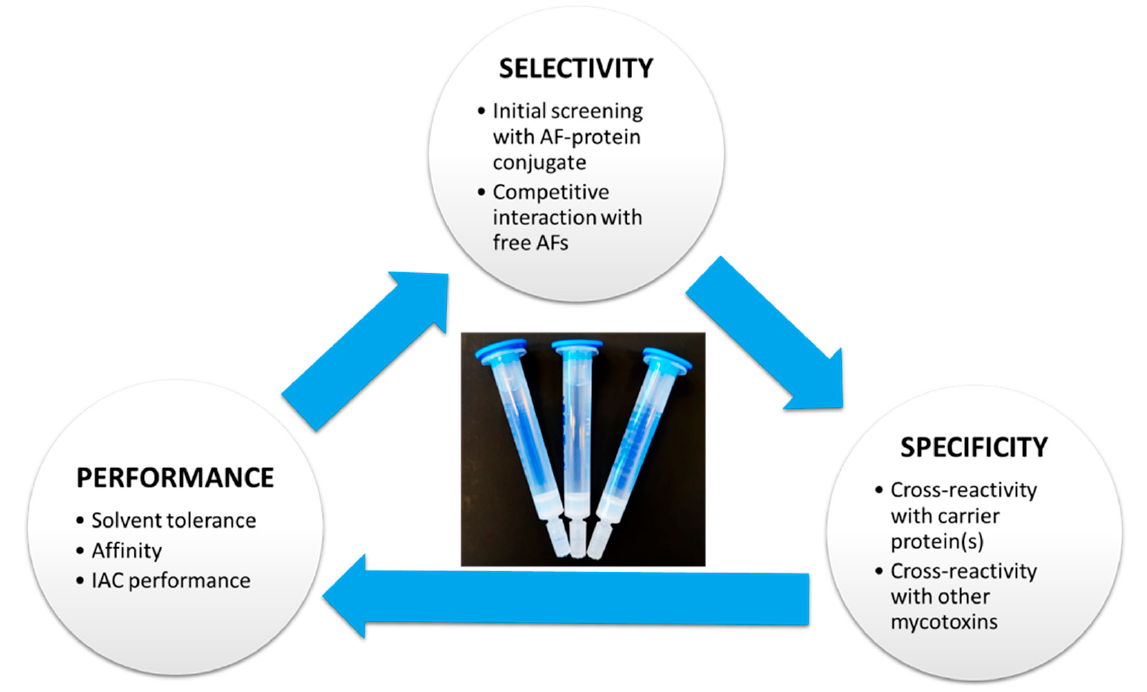
Figure 4. Scheme for AFs-specific antibodies to be used for immunoaffinity column development.